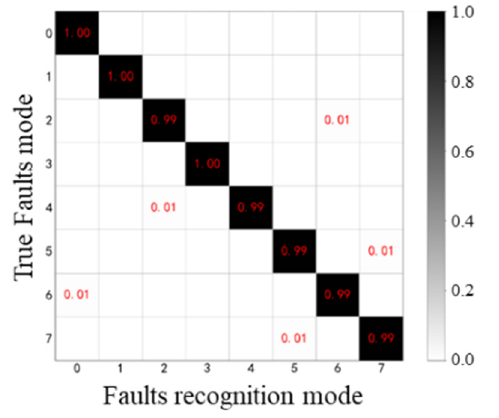
Figure 6. Confusion matrix for fault identification.